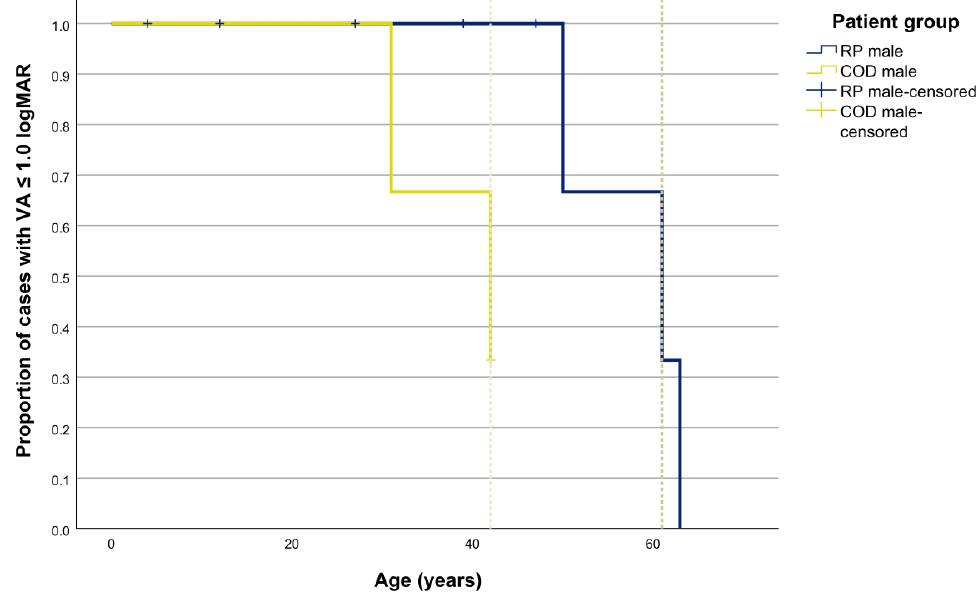
Figure 15. Kaplan–Meier survival analysis showing the ratio of male RP and male COD patients who reached legal blindness based on VA (BCVA ≥ 1.0 logMAR) with age. Dashed line represents when 50% of patients reached legal blindness.